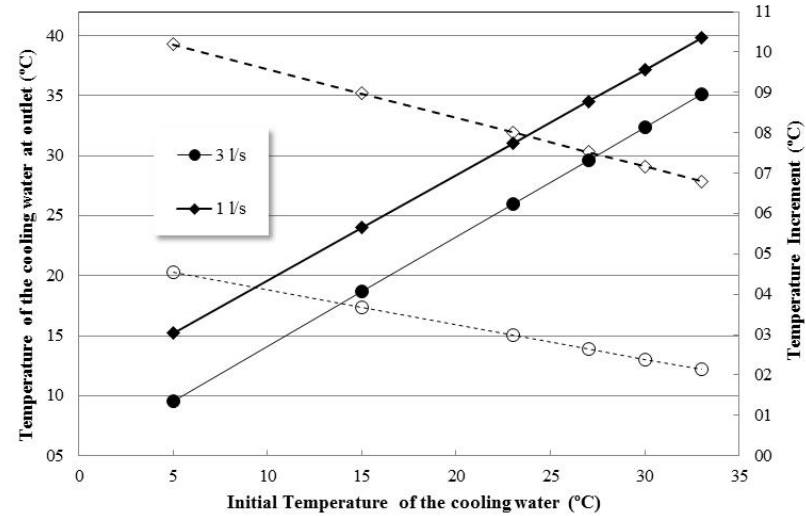
Figure 17. Absolute temperature at outlet (full symbols) and temperature increment (open symbols) of the cooling water as a function of the initial temperature of the cooling water, for two different flow rates.